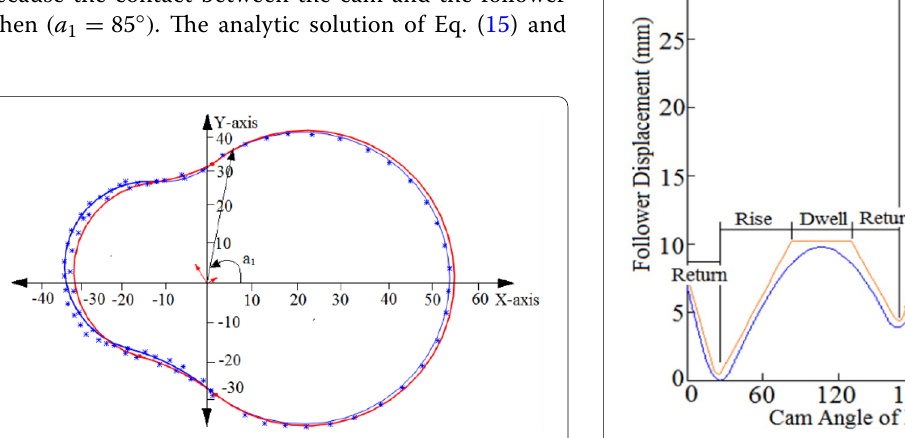
Figure 3 Verification of cam profile Figure 4 Verification of follower